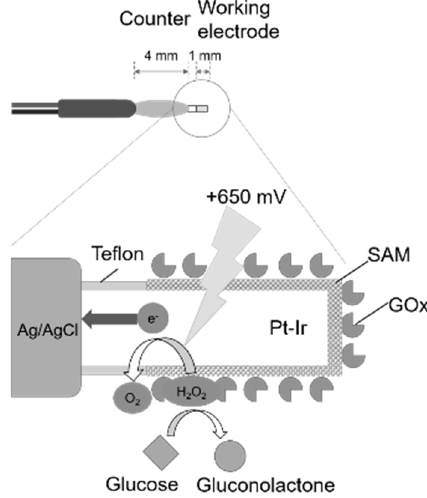
Figure 1. A schematic diagram of the glucose biosensors.